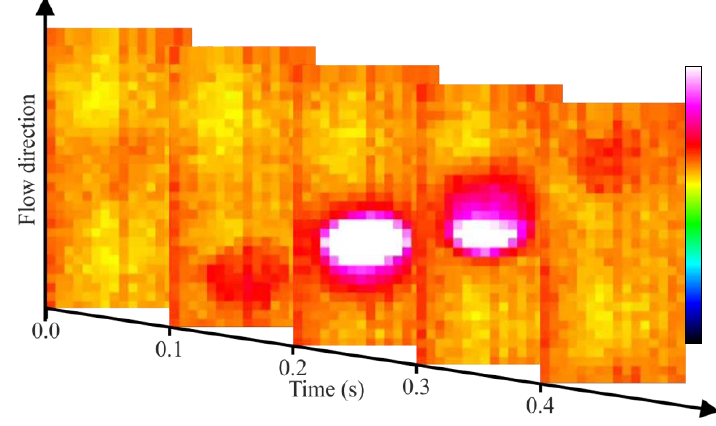
Figure 8. Two-phase flow involving air and crude oil.